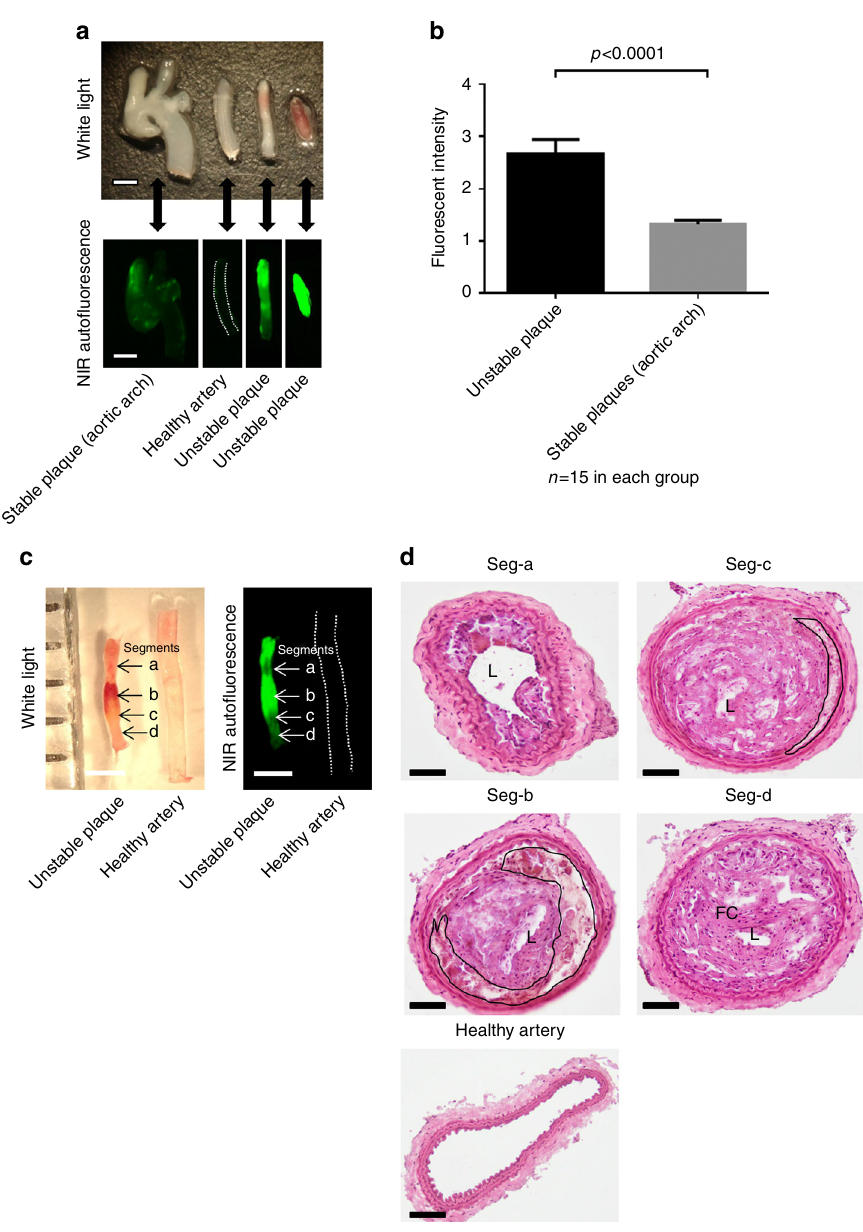
Fig. 2 NIRAF imaging and intraplaque hemorrhage in the TS mouse model. a Macroscopic samples ( upper photo ) of different arterial segments from the murine TS model: from left to right: aortic arch with adjacent vessels representing stable plaques, healthy carotid artery, unstable atherosclerotic plaque with modest intraplaque hemorrhage and unstable atherosclerotic plaque with extensive intraplaque hemorrhage (both segment I of different mice) and representative NIRAF pictures ( lower images ) of their corresponding arterial segments obtained with the Odyssey Infrared Imaging System ( n = 15). b Bar graph comparing NIRAF intensity (mean ± SEM) of unstable plaques to stable plaques in the tandem stenosis model in 15 mice. There was a signi fi cantly higher NIRAF signal in unstable plaques compared to stable plaques ( p < 0.0001, Student ’ s t -test). Unstable and stable plaques were de fi ned by histological features as outlined by Chen et al. 16 c White light ( left ) and NIR images ( right ) of an unstable atherosclerotic plaque in comparison to a healthy artery, which served as background control signal. NIRAF signals were mainly co-localized with the regions of gross intraplaque hemorrhage (arrow labeled with b ). d Histological images using hematoxylin and eosin staining of serial cross sections of the same samples shown in c (atherosclerotic plaque and normal healthy artery). Seg-a shows an intermediate lesion while seg-b exhibits extensive intraplaque hemorrhage ( black line indicates the hemorrhage region). Seg-c also exhibits modest intraplaque hemorrhage and seg-d shows a thick cap fi broatheroma. L, lumen, FC, fi brous cap, TS, tandem stenosis. Scale bars indicate 1 mm in a and c and 100 µ m in